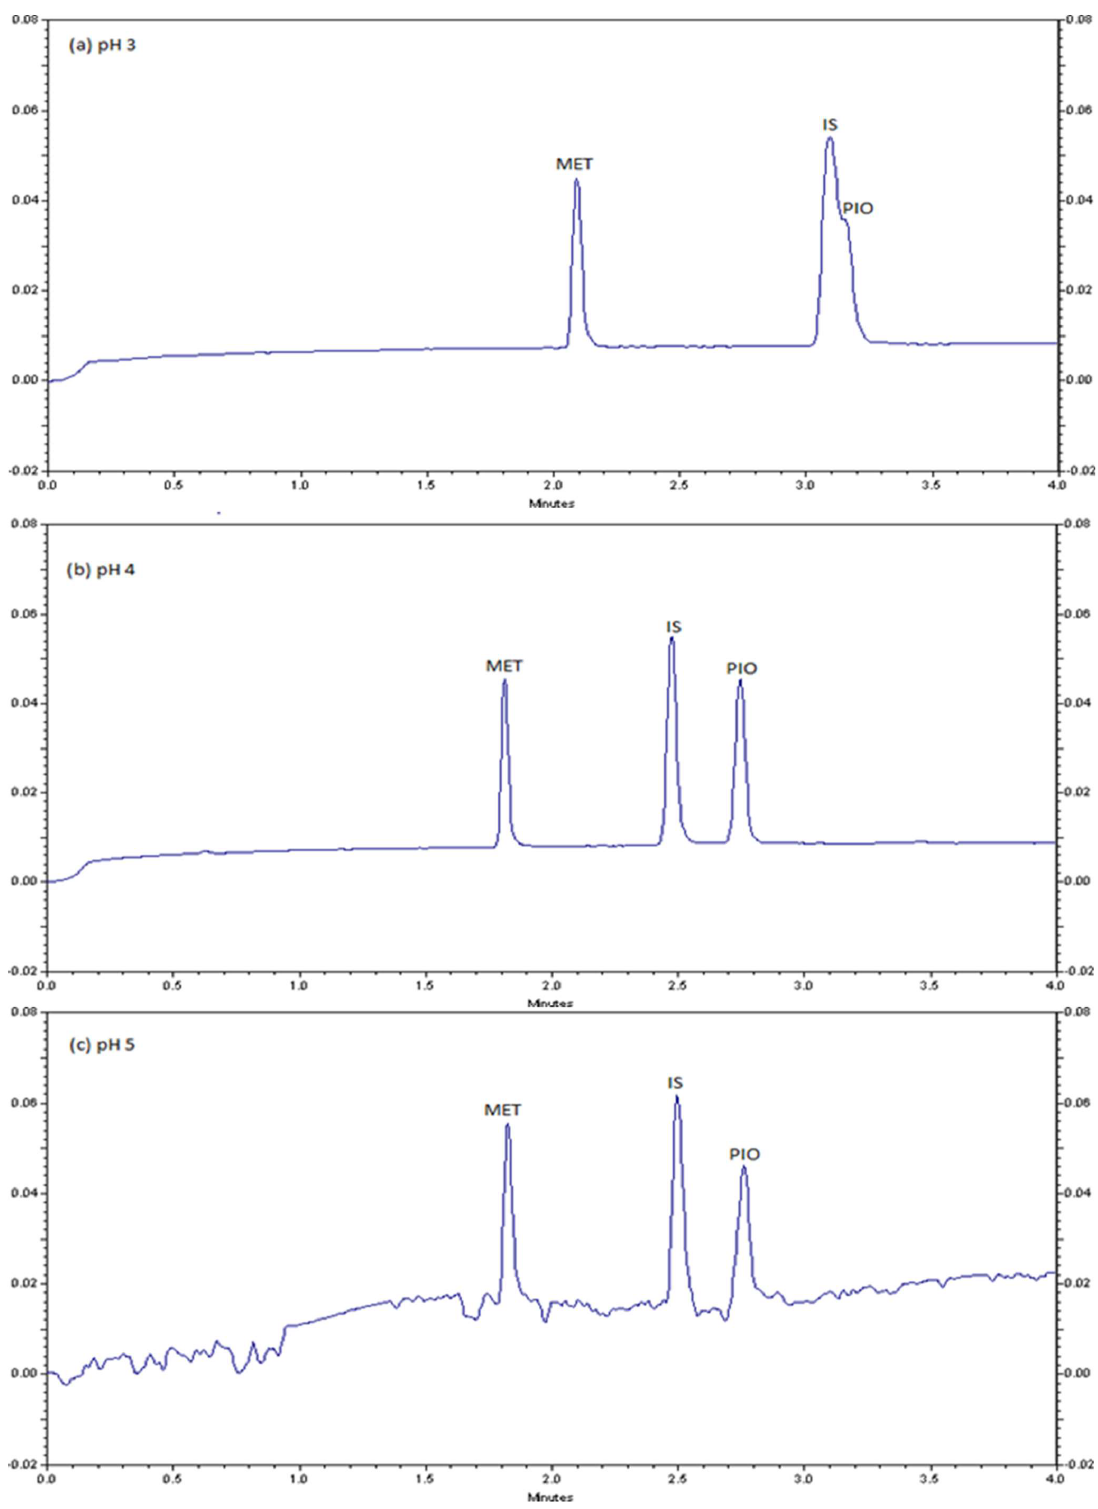
Figure 3. Typical electropherograms for application of the proposed capillary zone electrophoresis method ( a ) for the determination of 75 µ g/mL metformin (MET) in pharmaceutical formulation (Glucophage ® ), ( b ) 30 µ g/mL pioglitazone (PIO) in pharmaceutical formulation (Actos ® ) and ( c ) for 75 µ g/mL metformin (MET), and 30 µ g/mL pioglitazone (PIO) in synthetic mixture, in all cases 50 µ g/mL internal standard (IS), was